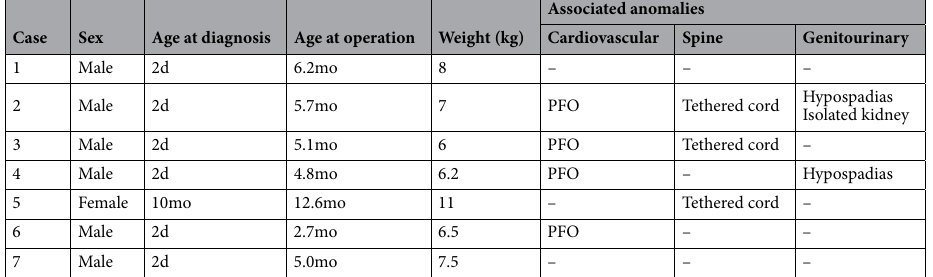
Table 1. Demographic data with SPF.